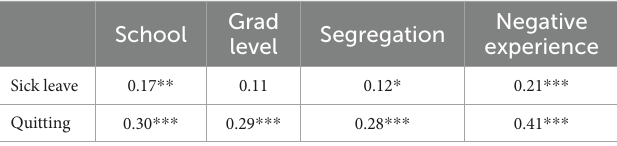
TABLE 4 Sick leave, assessment of quitting as a teacher, challenging behavior, segregation and negative